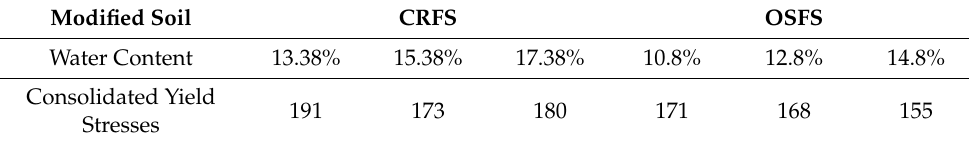
Table 6. Consolidation yield stress of modified soil with different water contents (kPa).